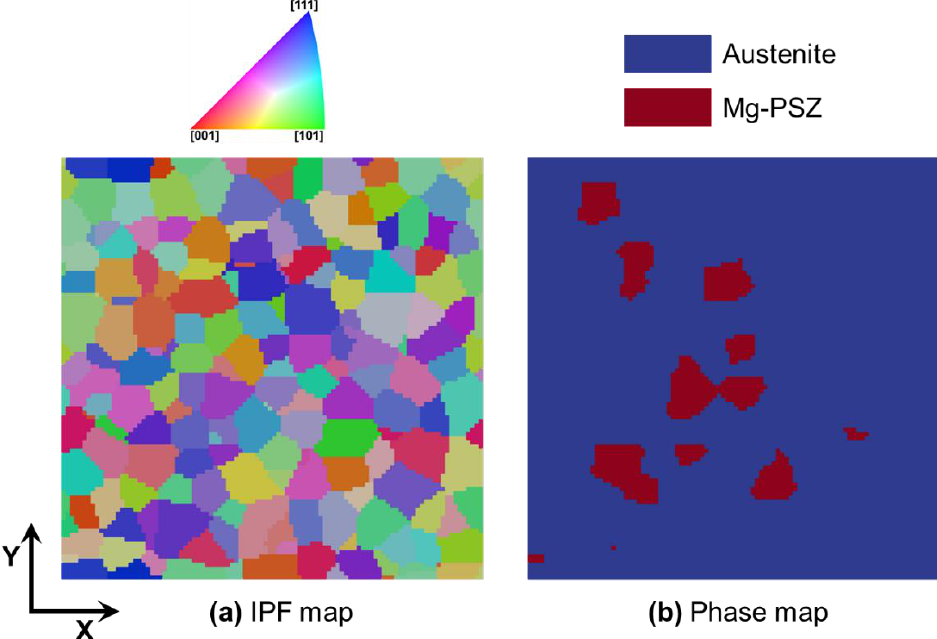
Figure 1. Generated 2D geometry file from the adopted microstructural data ( a ) Inverse pole figure (IPF) map where a different color represents each grain as per given IPF legend, ( b ) phase map representing the distribution of austenitic matrix (blue) and zirconia particles (red) within the constructed geometry. The heterogeneous distribution of zirconia particles of varying grain size is evident in this figure.